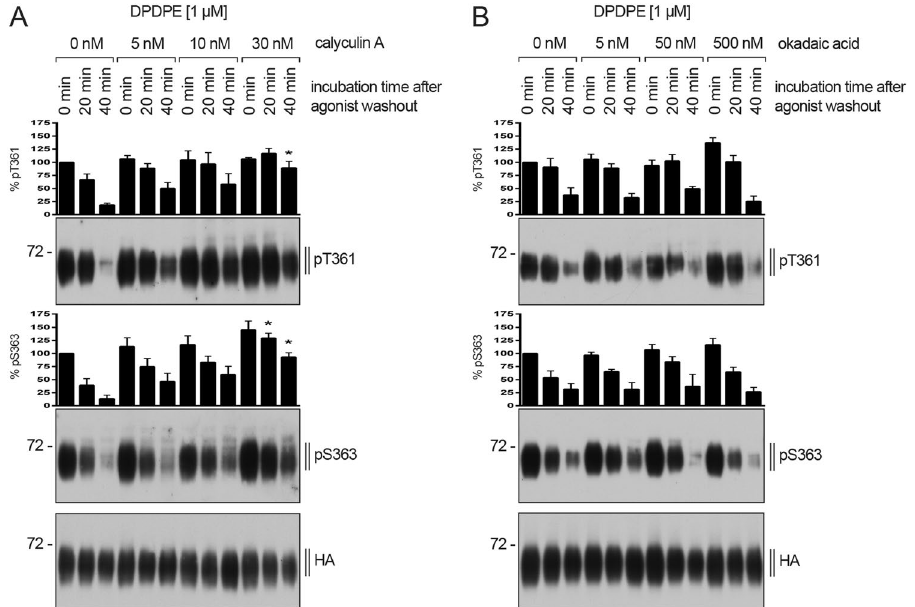
Figure 9. Inhibition of DOP receptor dephosphorylation by calyculin A but not okadaic acid. ( A,B ) HEK293 cells stably expressing HA-hDOP receptor were either preincubated with the indicated concentrations of ( A ) calyculin A or ( B ) okadaic acid for 30 min at 37 °C and then stimulated with 1 µ M DPDPE for 10 min at 37 °C. Subsequently, cells were washed three times with ice cold citrate buffer and then incubated in serum-free medium in the absence of DPDPE for 0, 20 or 40 min in the presence of the above indicated concentrations of (A) calyculin A or (B) okadaic acid at 37 °C. Lysates were immunoblotted with antibody to pT361 or pS363. Blots were stripped and reprobed with the anti-HA antibody. Densitometry readings, above the blots, were normalized to those in DPDPE-stimulated cells (0 nM and 0 min), which were set to 100%. Data are mean ± SEM from three independent experiments. * p < 0.05 vs. DPDPE controls by one-way ANOVA with Bonferroni’s post-hoc